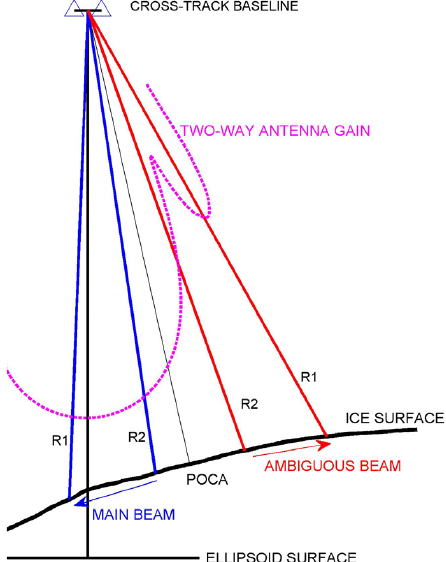
Fig. 1. Cryosat is oriented such that the baseline formed by the two Figure 1. Cryosat is oriented such that the baseline formed by the 2 receive antennas is receiving antennas is oriented perpendicular to both the along-track oriented perpendicular to both the along-track direction and to the normal to the WGS84 direction and to the normal to the WGS84 ellipsoid. Each cross- ellipsoid. Each cross-track scan line will contain a unique estimate of the ‘point-of-closest- track scan line will contain a unique estimate of the POCA on the approach (POCA) on the ice surface, followed in delay time by the sum of returns from both ice surface, followed in delay time by the sum of returns from both sides of the POCA. With a suitable geometry the returns from the ambiguous region can be sides of the POCA. With a suitable geometry the returns from the much weaker than those from the main beam underneath the satellite which allows the ambiguous region can be much weaker than those from the main mapping of position and height of main beam footprints. The dashed magenta line illustrates beam underneath the satellite which allows the mapping of position and height of main-beam footprints. The dashed magenta line il- lustrates diagrammatically the dB variation in cross-track two-way gain. Note that the angles have been exaggerated for clarity; the first side lobe in the pattern occurs at ∼ 2 ◦ from nadir and represents a two-way power level of − 40dB with respect to the power at